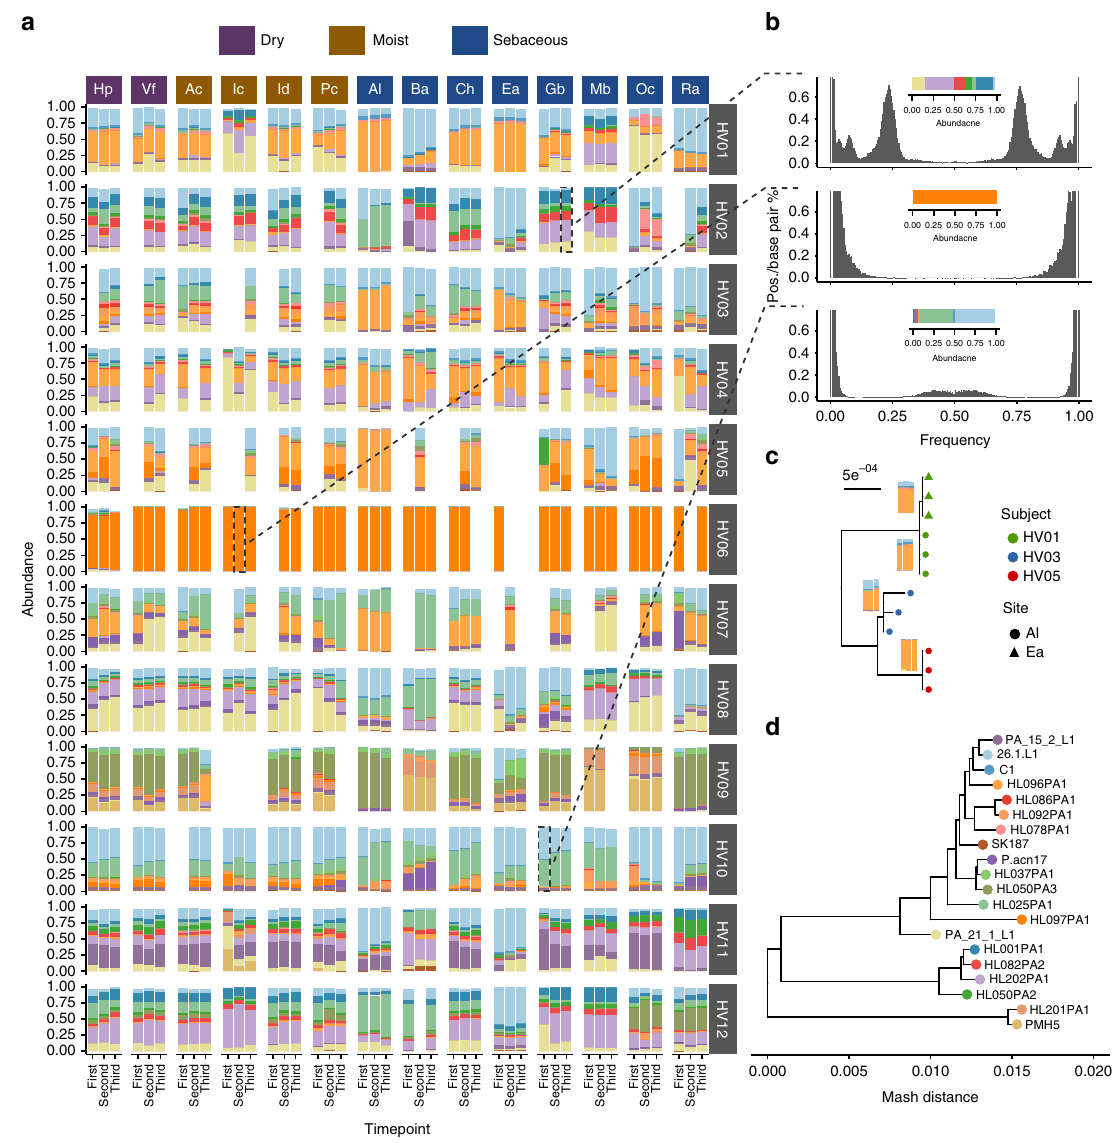
Fig. 3 StrainEst analysis reveals interpersonal and intersite differences in the strain composition of P. acnes communities in human skin metagenomic samples. Three skin samples from 14 sites from a cohort of 12 healthy subjects were collected at three different times separated by long (1 – 2 years between timepoints 1 and 2) and short (2 – 3 months, between timepoints 2 and 3) time intervals. a Each individual is colonized by a speci fi c mixture of strains. The relative abundances of the subject-speci fi c mixture vary across the different body sites, but are conserved across the different sampling times. The site codes are described in the original work. The strain identi fi ers are reported in ( d ). b To verify that complex strain mixtures are not an artifact due to the presence of one strain not represented in the collection of genomic reference sequences, we show for three representative samples the distribution of frequencies of the four possible nucleotides at each allelic position. c Where a single strain was dominant, we could use the consensus (containing the most supported allele in each position) SNV pro fi le to compare the strains from different subjects/body site. In this example, strains were classi fi ed as HL096PA1 by StrainEst cluster by subject and body site. The variability between pro fi les from subject HV03 is probably due to the lower relative abundance of the dominant components (see also a). In this case, it is likely that the presence of a second strain with nonnegligible relative abundance introduces a source of noise in the consensus SNV pro fi le. d Neighbor joining tree of the reference strains. Leaves are colored using the same schema as in ( a ) site-speci fi c population structure of this group of species, i.e., how amongst three main oral sampling sites of the HMP, i.e., the many individual strains/species were present in each sample. To tongue dorsum, the supragingival plaque and the buccal mucosa verify if, besides the dominant component, samples from the (Fig. 5 and Supplementary Fig. 10). While the majority of samples different sites contained complex mixtures of other species and the from the tongue dorsum contained exclusively Neisseria sub fl ava , site-speci fi c structure of these communities, we analyzed 689 oral most samples from the other two sites appeared to contain much samples from the Human Microbiome Project, using a database of more complex mixtures of species. Interestingly, there was a clear 212 genomic sequences of human associated neisseriae. The core distinction between the tongue dorsum and the supragingival genome of these species contained 25.393 SNV positions and the plaque, and the buccal mucosa was intermediate between the two, genomes were grouped into 79 reference clusters by the StrainEst with a fraction of the samples clustering together with samples pipeline (Supplementary Table 5). We found striking differences from the tongue dorsum and a smaller fraction clustering with NATURE COMMUNICATIONS | 8: 2260 | DOI: 10.1038/s41467-017-02209-5 |